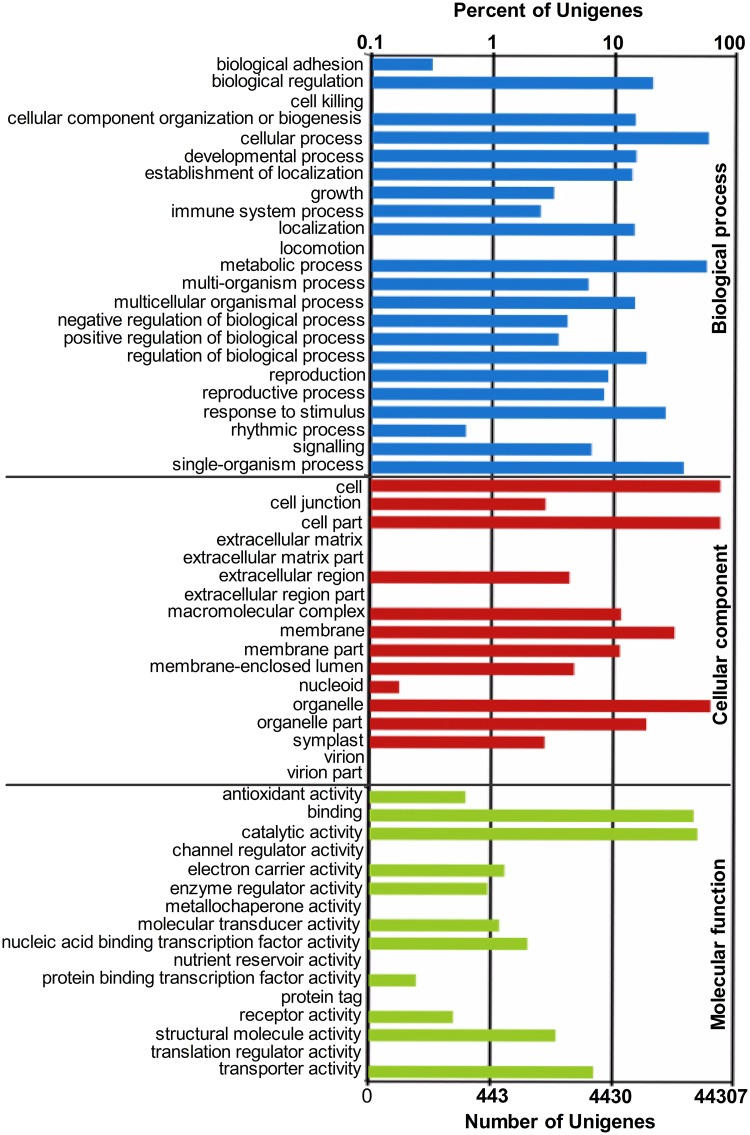
Histogram presentation of gene ontology (GO) classification.The up and down x-axis indicates the percentage and number of a specific category of genes in that main category respectively.